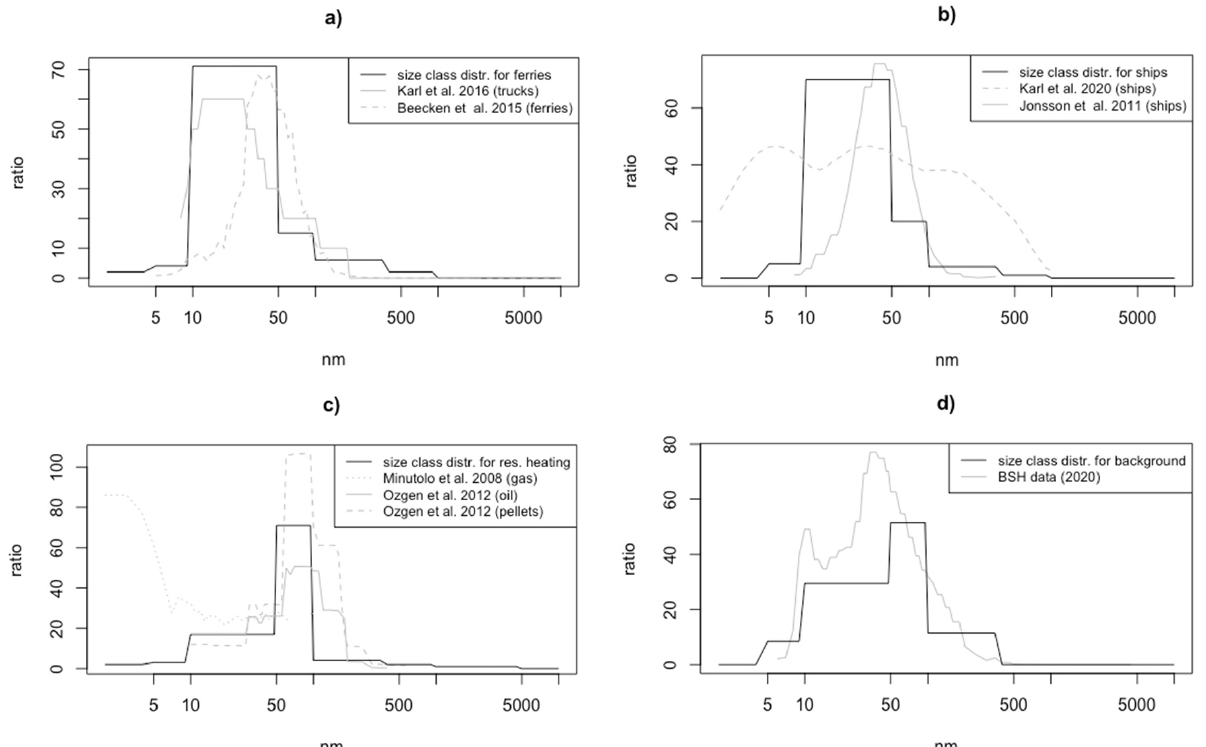
Figure 1. Emission size spectra of different emission sectors (black): ferryboats and road traffic ( a ), ocean-going ships ( b ), residential heating ( c ), and background concentration (BSH station Wedel) ( d ) based on the respective size distributions reported by other studies, provided as grey lines. Solid black lines show the representation of the size distribution in the EPISODE-CityChem model.